Question: How would you classify this visualization?
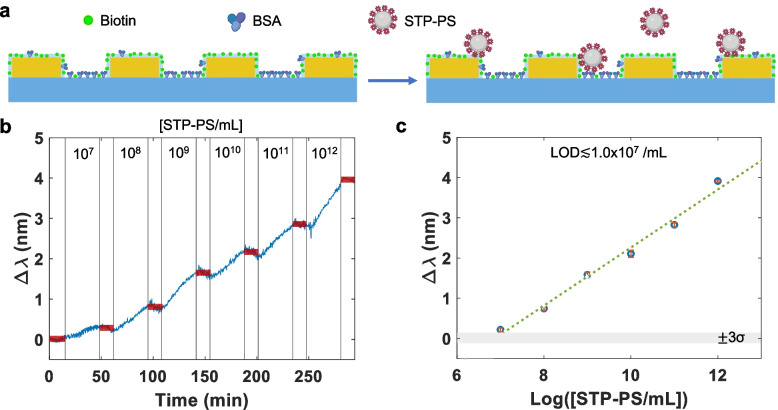
Answer: bar